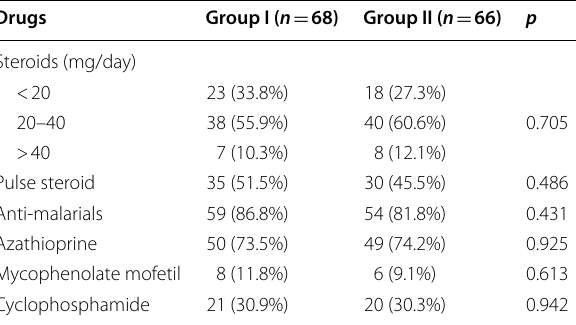
Table 5 Comparison between the studied groups according to